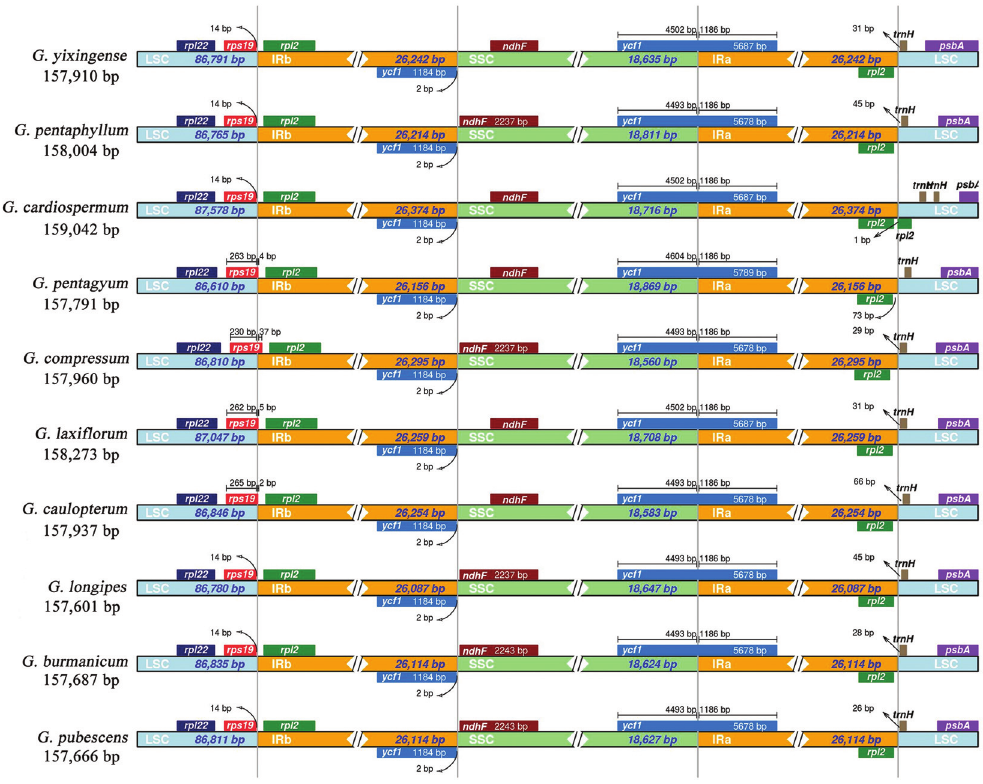
Figure 2 - Comparison of the LSC, IR and SSC junction positions among ten Gynostemma chloroplast genomes. Colored boxes for genes represent the gene